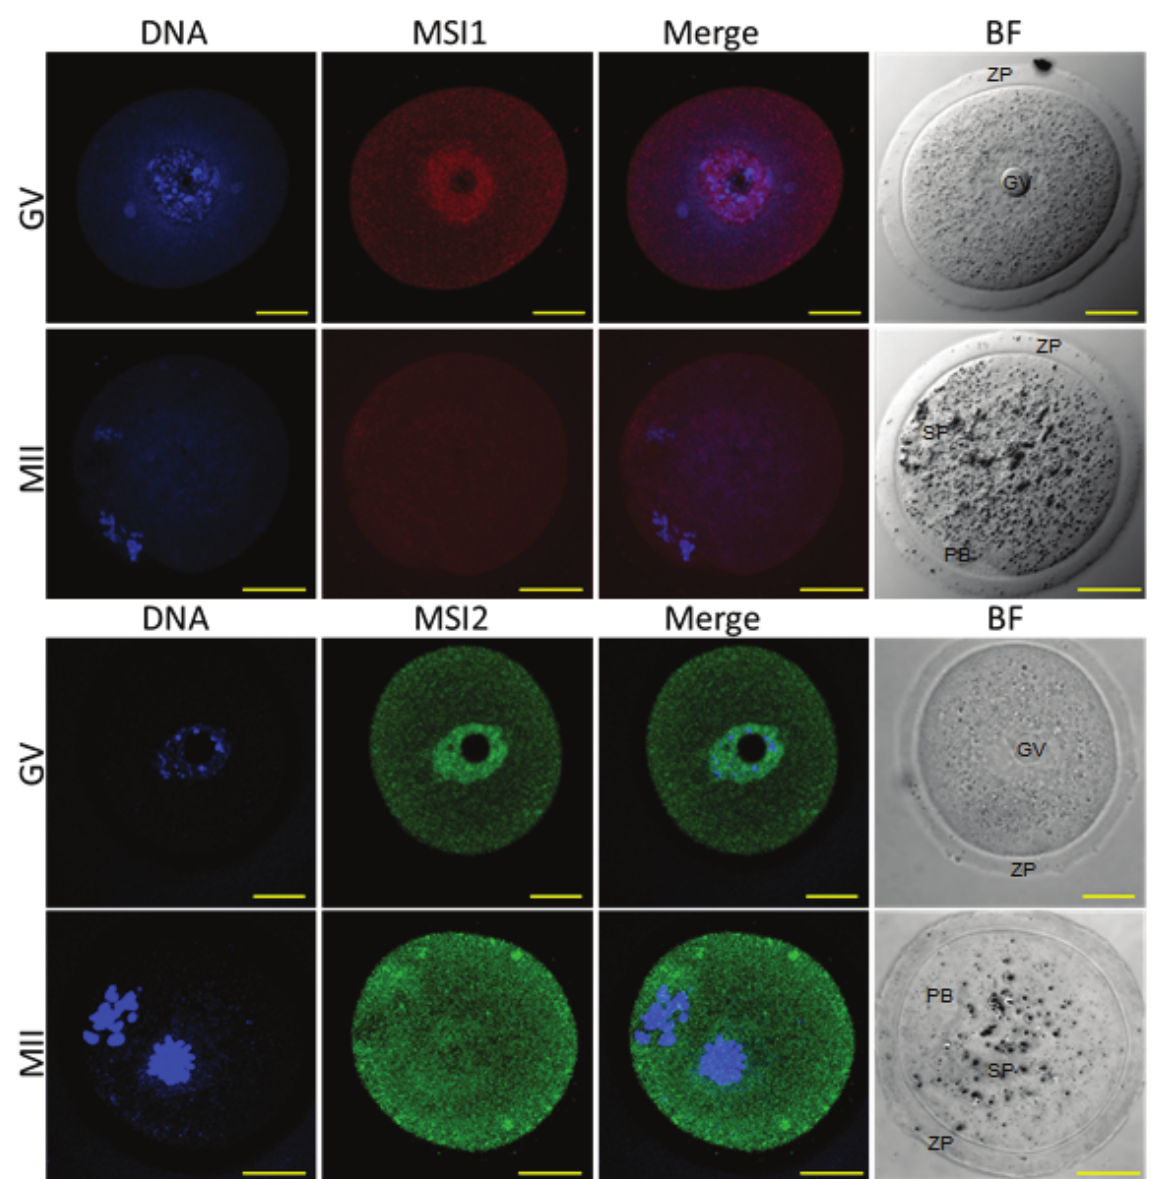
Figure 4. Immunocytochemistry of Musashi in germinal vesicle ( GV ) and metaphase II ( MII ) oocytes. Mouse oocytes were probed for antibodies against MSI1 (red) and MSI2 (green), and counter-stained with DNA marker Hoechst (blue). Representative images show Z-stack of total oocyte. Bright-field (BF) images were taken alongside confocal immunofluorescent microscopy. In BF images GV = germinal vesicle, ZP = zona pellucida, PB = polar body, SP = MII spindle. Scale bar = 20 (cid:3)m. Consistent for n =